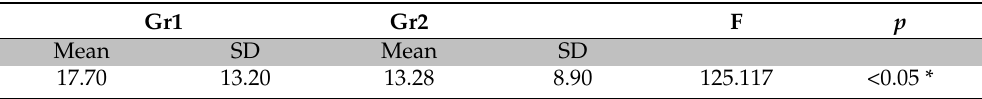
Table 12. Effect of between factor (group) on task 4 (ESSE).